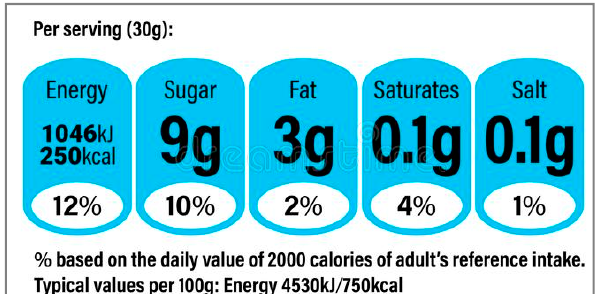
Figure A3. Reference Intake Label (EU) provides the energy content in both kilojoules and kilocalories